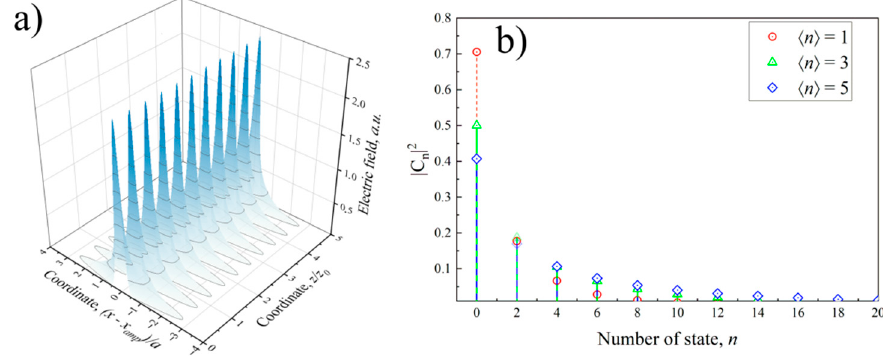
Figure 3. Squeezed vacuum state of the spatial transverse modes of the beam propagating in the waveguide with the parabolic profile of the susceptibility. ( a ) Squared amplitude of the electric field strength for ⟨𝑛⟩ = 1 . ( b ) Distribution over stationary states for different average numbers of quanta.